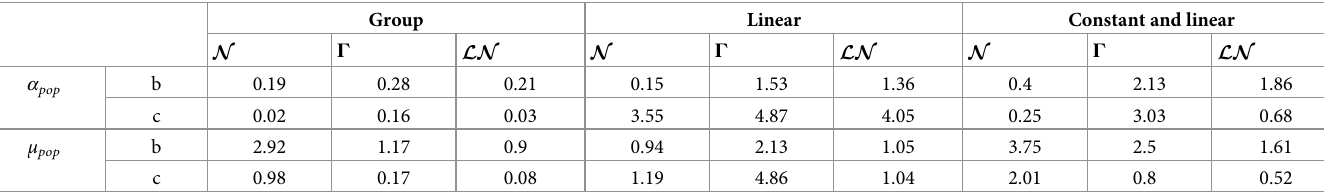
Table 1. RSE for the parameters b and c True values were b � = 0.3 for group effect, b � = 0.7 for linear and constant and linear and c � = 0.5 for normal distribution, c � = 0.05 for gamma distribution and c � = 0.13 for log-normal distribution, except for linear effect, in which c � = 0.1 independently of the distribution. Group Linear Constant and linear N LN